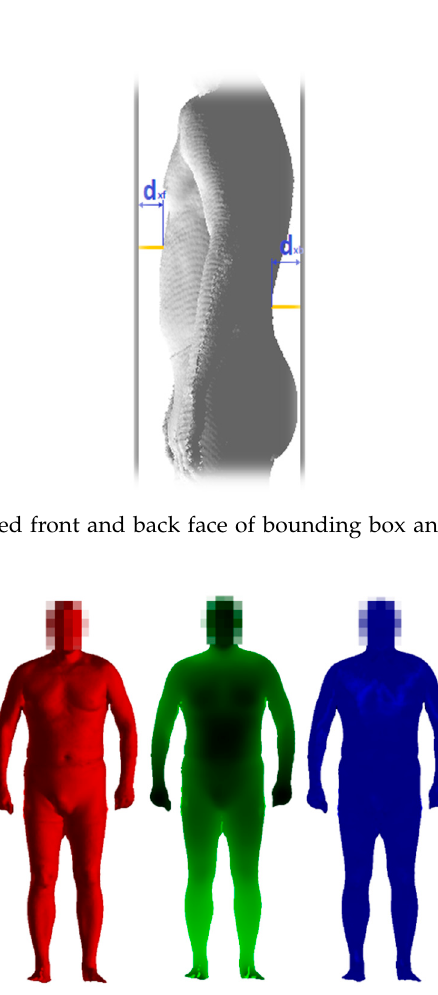
Figure 11. A visualization of calculated layers values for the orthogonal projection: light intensity (red), depth (green) and curvature (blue).